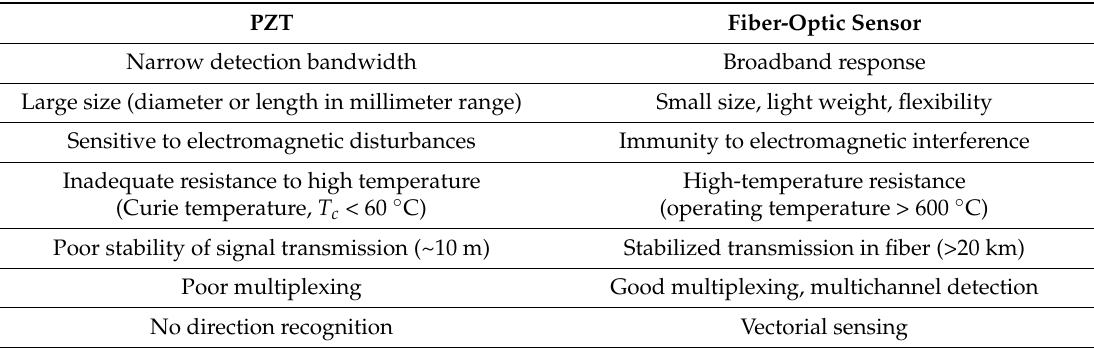
Table 3. Comparison between PZT and fiber-optic ultrasonic